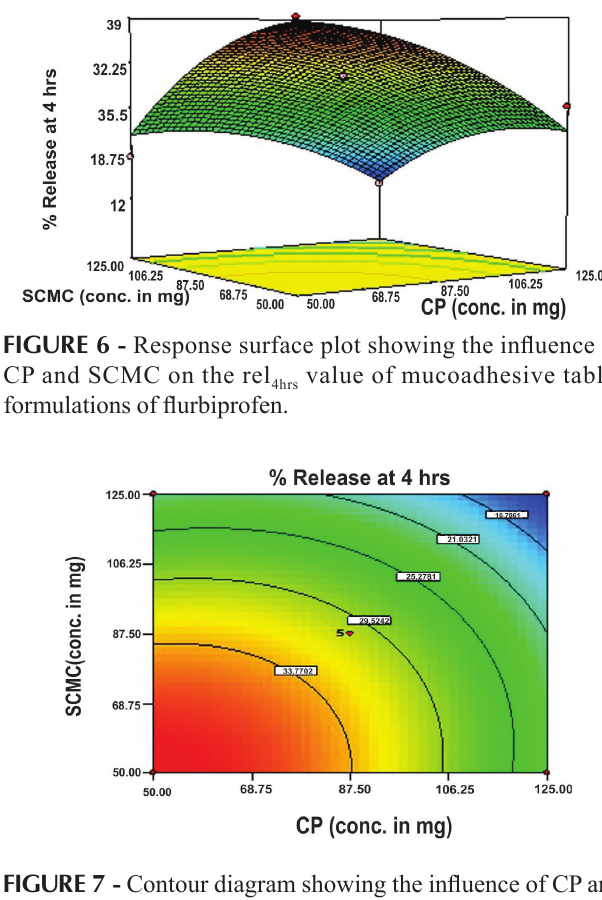
FIGURE 9 - Contour diagram showing the influence of CP and SCMC on the rel value of mucoadhesive tablet formulations 12hrs of